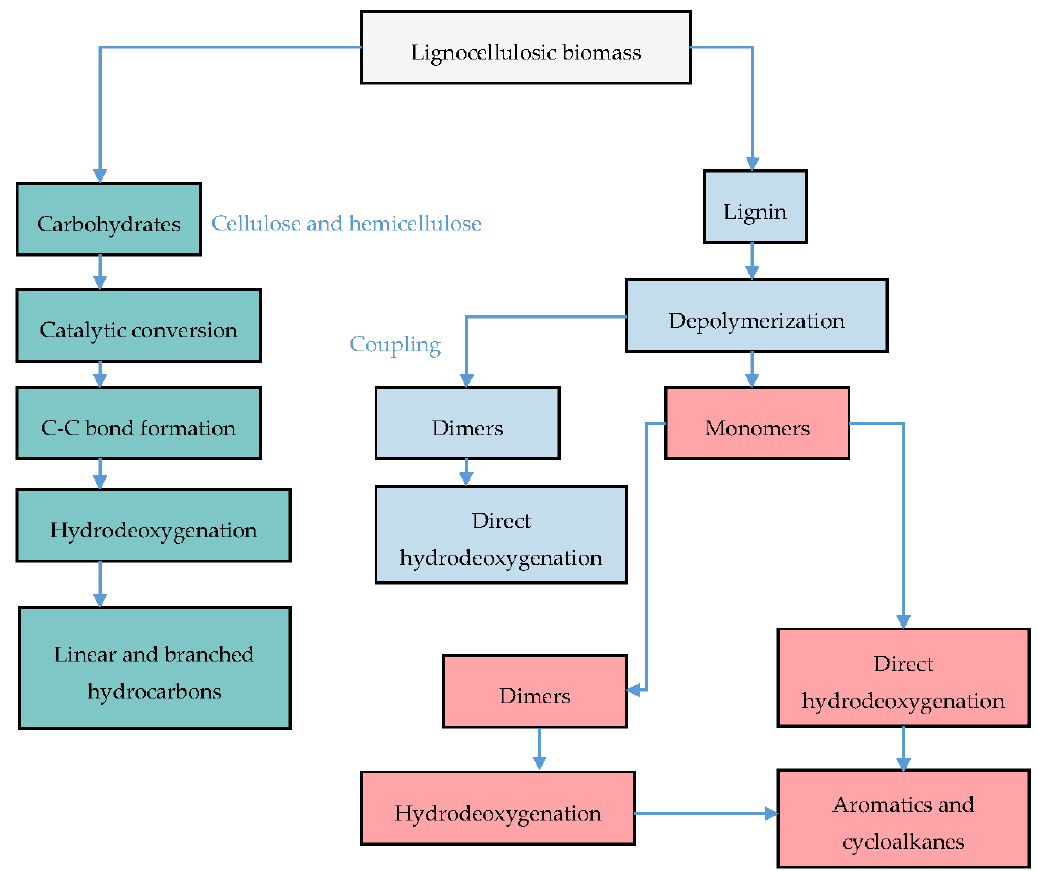
Figure 4. Hydrothermal conversion of lignocellulosic biomass (carbohydrates and lignin) to hydrocarbons, aromatics, and cycloalkanes